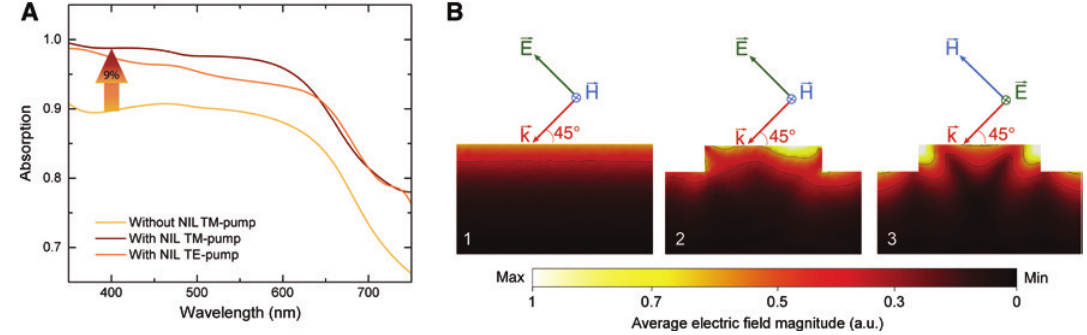
Figure 4: Calculations. (A) Theoretically calculated absorption spectra from a flat MAPbI perovskite film with thickness 600 nm (yellow), nanostructured film 3 for two orthogonal polarizations of an incident light. (B) Calculated near-field distributions in the sub-surface layer of smooth (1) and nanostructured (2 and 3) MAPbI at different polarizations (2–TM and 3–TE) of the incident 3